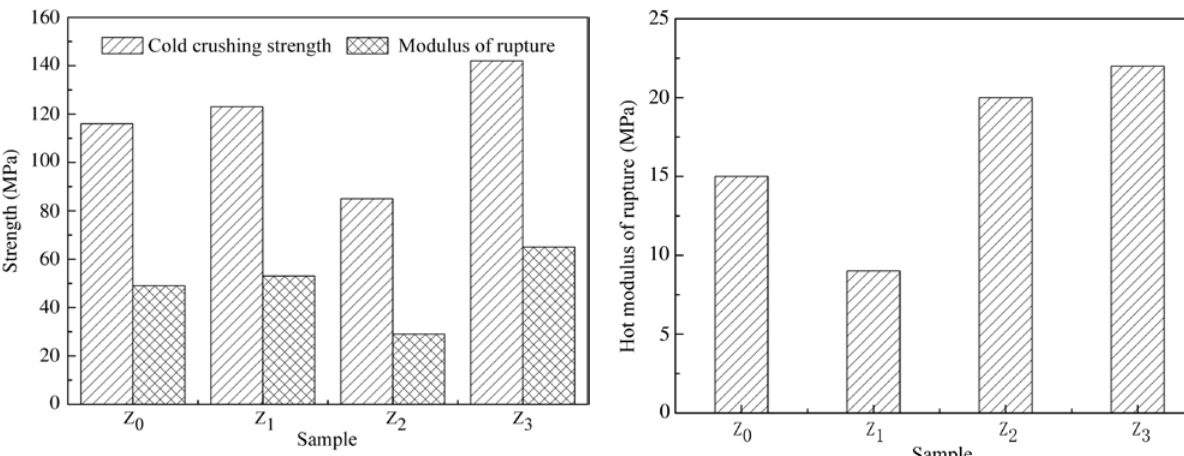
Figure 3 Cold crushing strength and modulus of rupture of samples.